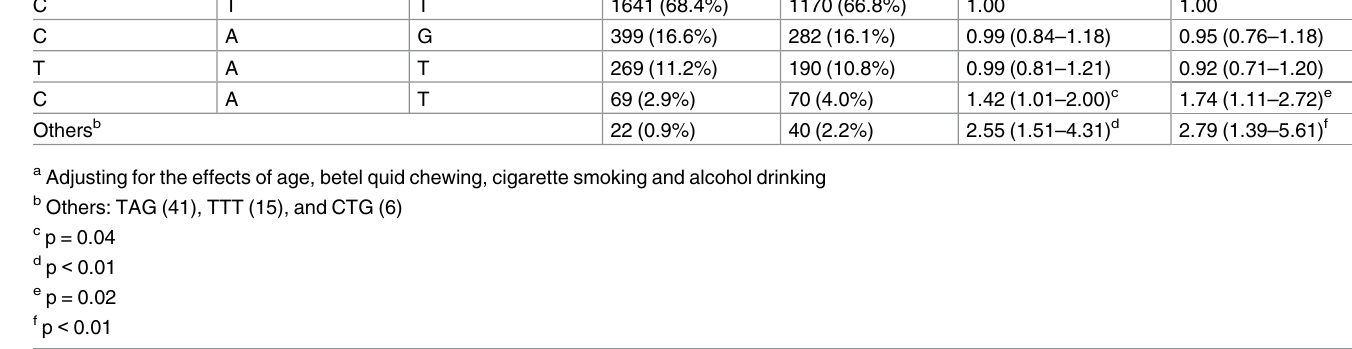
Table 5. Frequencies of AURKA haplotypes in OSCC patients and control subjects. Haplotype block